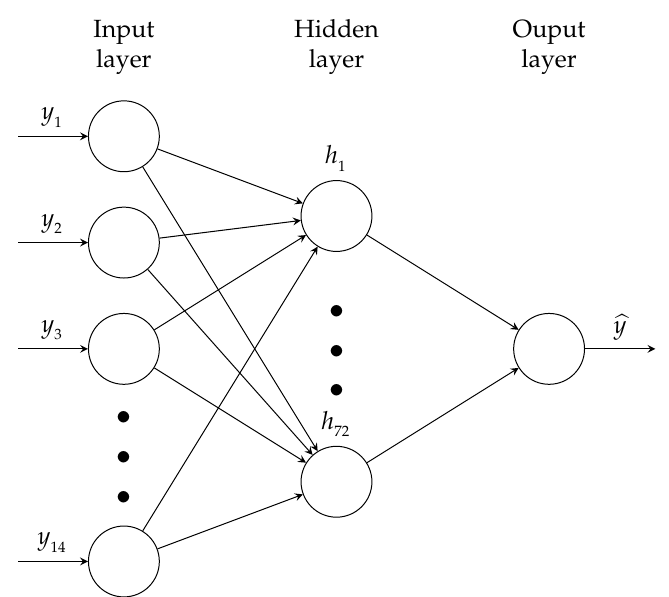
Figure 1. ANN proposed architecture. There are 14 inputs. The hidden layer is set to 72 nodes. The output layer is the estimated temperature of the low-speed shaft at time t